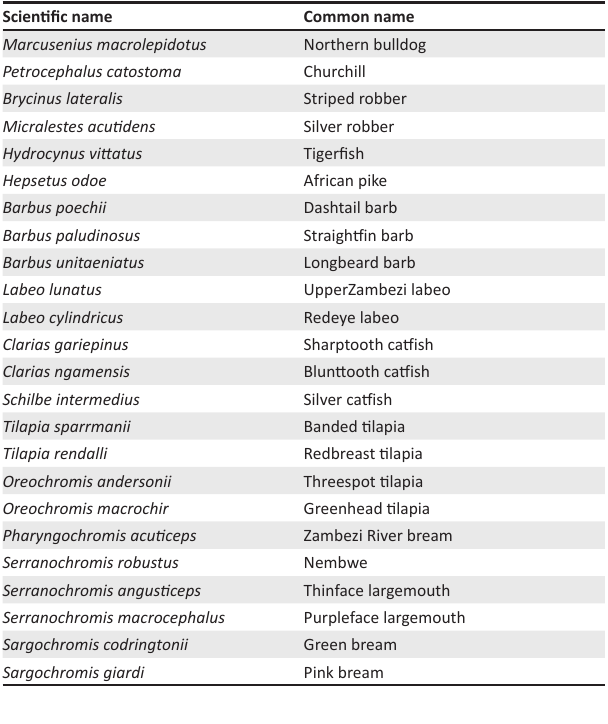
TABLE 1: List of fish species with presumptive macroscopic lesions of epizootic ulcerative syndrome collected in Caprivi from February 2007 to October 2008.